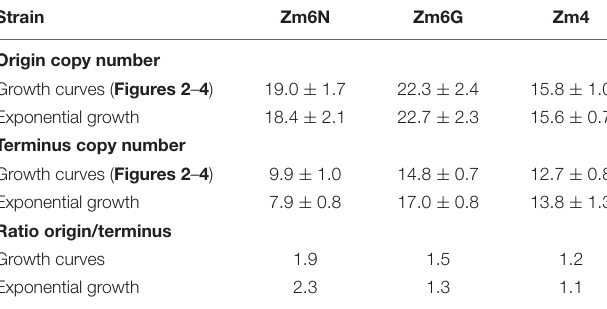
The table summarizes the average values that were obtained from early exponential to early stationary phase (“growth curves”) and results from additional control cultures that were grown to mid-exponential growth phase (“exponential